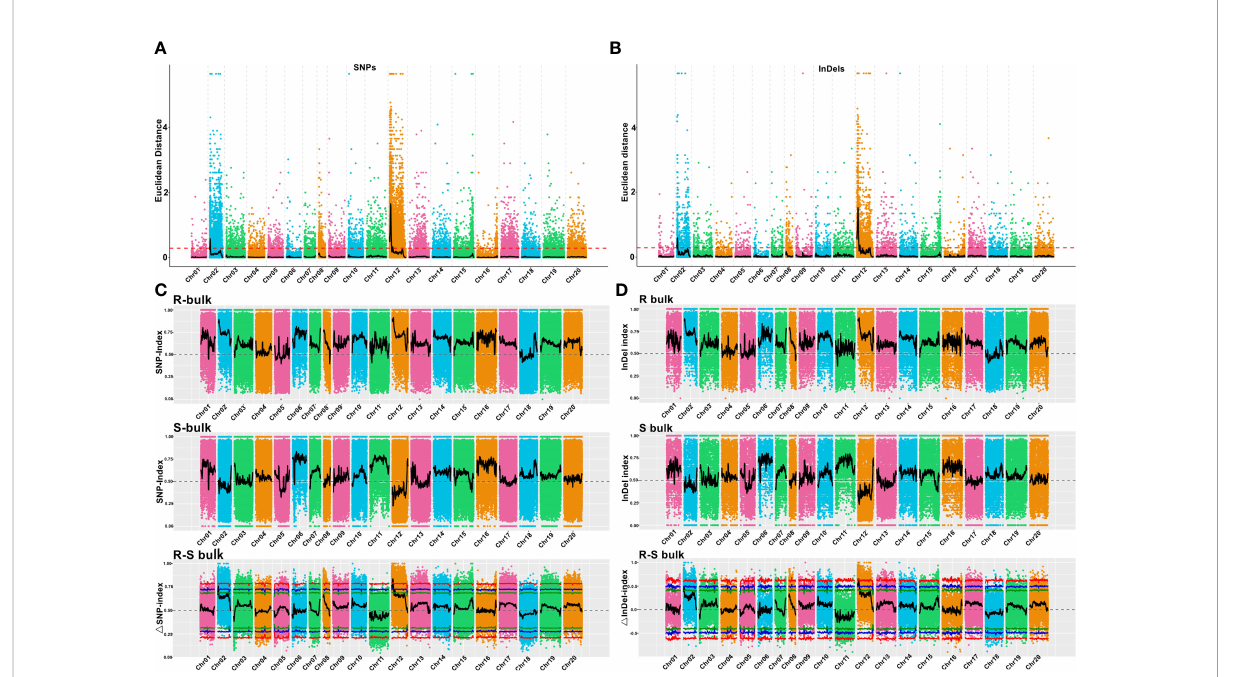
FIGURE 2 Euclidean distance (ED) value distribution of SNPs/InDels and SNP/InDel-index of R- and S-bulks and D (SNP/InDel-index) plots generated by sliding-window analyses of 20 cultivated peanut chromosomes. (A, B) Euclidean distance (ED ) value distribution of SNPs and InDels in 20 chromosomes. The x-axis represents the chromosome name, the colored dots represent ED values, the black lines represent the fi tted ED values (with 2Mb windows sliding in 10 kb steps), and the red dotted lines represent associated thresholds. (C, D) SNP/InDel-index of R- and S-bulks and D (SNP/InDel-index) plots generated by sliding-window analysis of cultivated peanut chromosomes. The physical positions of chromosomes are displayed on the X-axis and the average SNP/InDel-index in each 2-Mb physical interval with a 10-kb sliding window is displayed on the Y-axis. Two candidate genomic regions (marked in yellow) were de fi ned using the criteria: average SNP/InDel- index > 0.9 in the R-bulks and average P < 0.05. The red, blue, and green lines represent the thresholds at con fi dence levels of 0.99, 0.95, and 0.90,